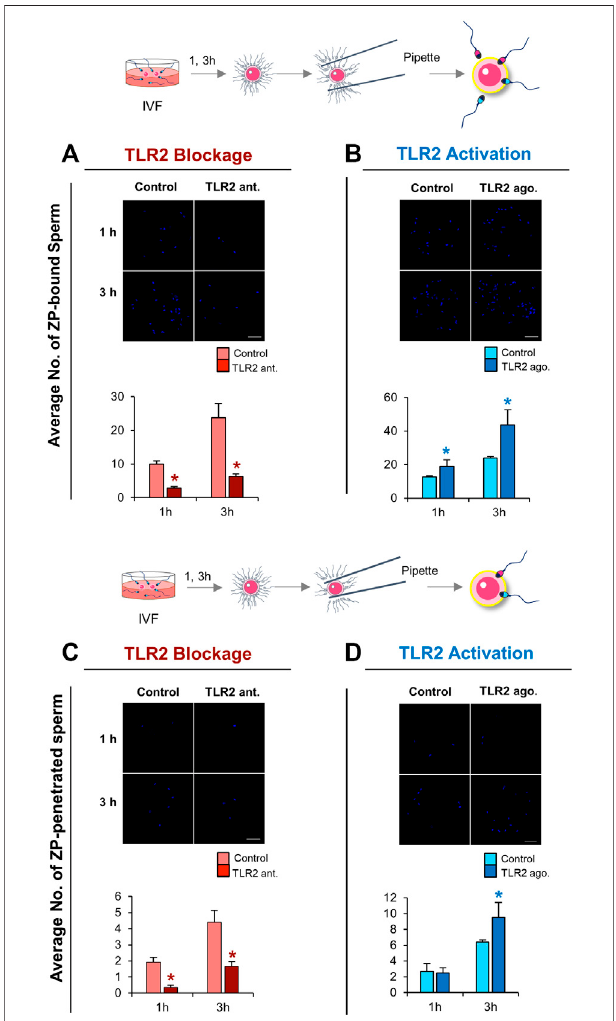
FIGURE 4 | TLR2 pathway mediates sperm-ZP binding and sperm-ZP penetration abilities. Sperm were pre-treated by TLR2 antagonist (100 µM) or TLR2 agonist (100 ng ml − 1 ) for 30 min, washed, and co-cultured with cumulus-free oocytes (n = 15 – 20) for 1 and 3 h. Sperm-oocyte complexeswerewashedtoremoveZP-looselyattachedspermwhileonlyZP- strongly attached sperm were counted as sperm-ZP binding ratio after stainingwithHoechst33342andobservedat×200magni fi cation.Spermwith heads embedded in the ZP or perivitelline space were counted as sperm-ZP penetration ratio (A) Representative image of zona-binding observed in control and TLR2 antagonist treated group and the average number of sperm bound to the ZP at 1 and 3 h was counted (B) Representative image of zona- binding observed in control and TLR2 agonist treated group and the average number of sperm bound to the ZP at 1 and 3 h was counted (C) Representative image of zona-penetration observed in control and TLR2 antagonist treated group and the average number of sperm penetrated to the ZP at 1 and 3 h was counted (D) Representative image of zona-penetration observed in control and TLR2 agonist treated group and the average number of sperm penetration to the ZP at 1 and 3 h was counted. Data reported as means ± S.E.M of three independent experiments. Different superscript asterisks denote a signi fi cant difference ( p < 0.05). Scale bar = 50 μ m.